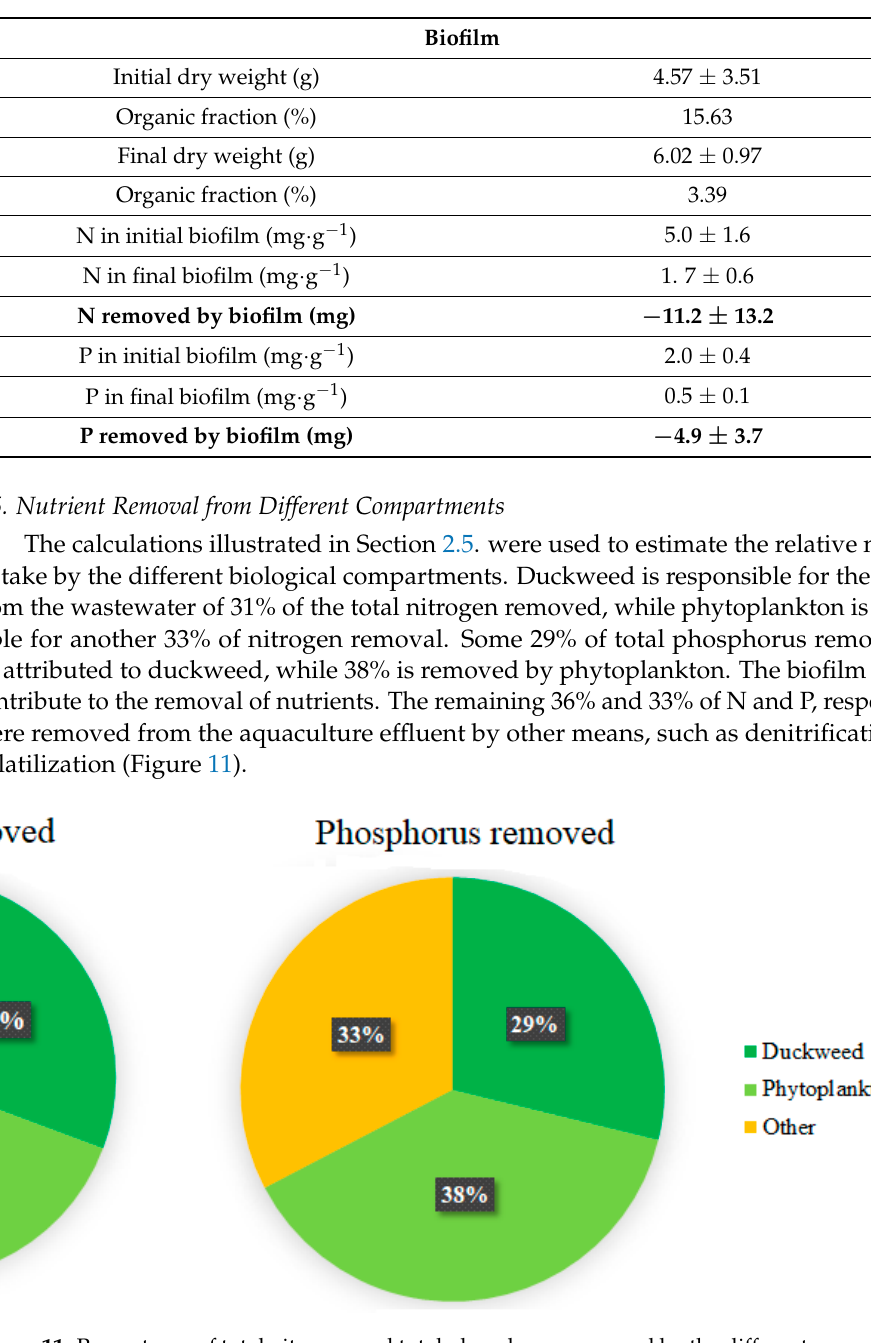
Table 4. Biofilm weight, % of organic matter, and nutrient content at the start and at the end of the experiment.